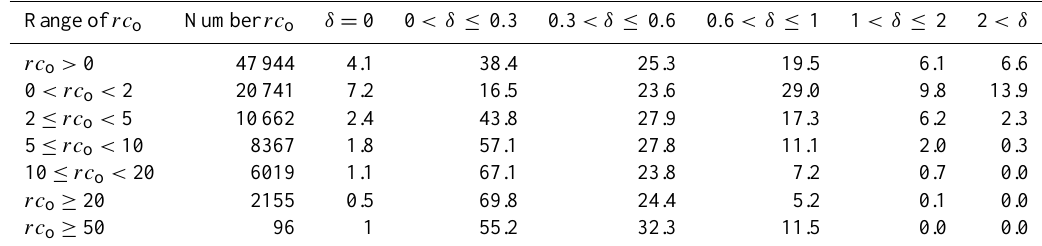
Table 2. Repartition (%) of the absolute relative errors ( δ , Eq. 5) across different ranges of observed rainfall ( rc o ) events for the observed data of the Scottish validation gauges, in which days were only retained when the tipping bucket was at least 5km away from any of the daily gauges used to derive the rainfall